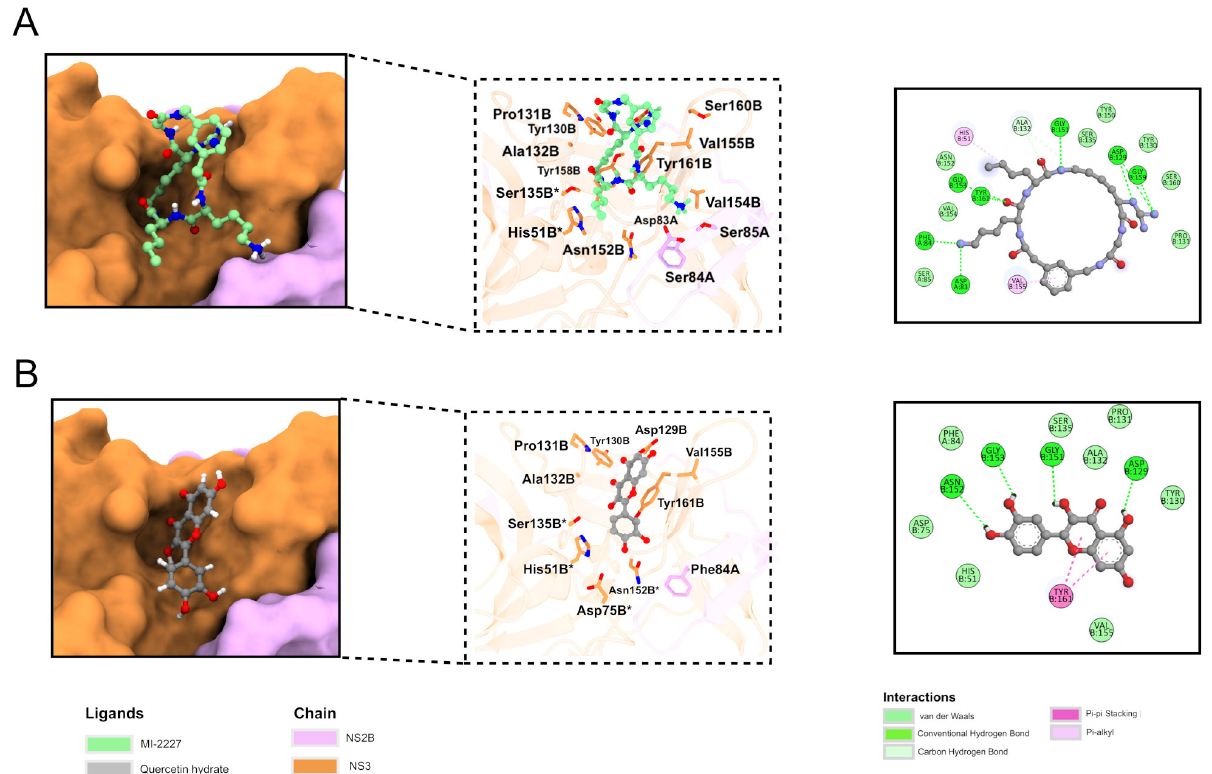
Figure 5. Binding mode of MI-2227 ( A ) and quercetin hydrate ( B ). Right panel: NS2B-NS3 is repre- sented as a surface, while the ligands are shown as green (MI-2227) and gray (quercetin hydrate) stick structures. The NS2B and NS3 chains are presented as pink and orange, respectively. Center panel: protein is shown as a transparent ribbon, and residues interacting with the ligand are represented as stick structures. Left panel: 2D diagram of protein/ligand interaction. Residues that are part of the catalytic triad are marked with *.